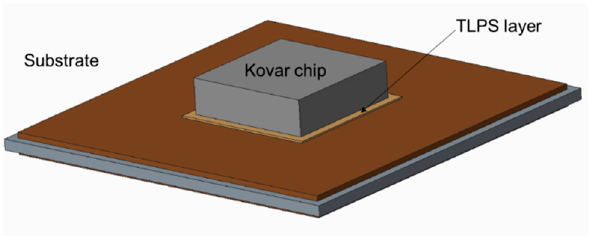
Figure 2. Schematic of a die-attached specimen.